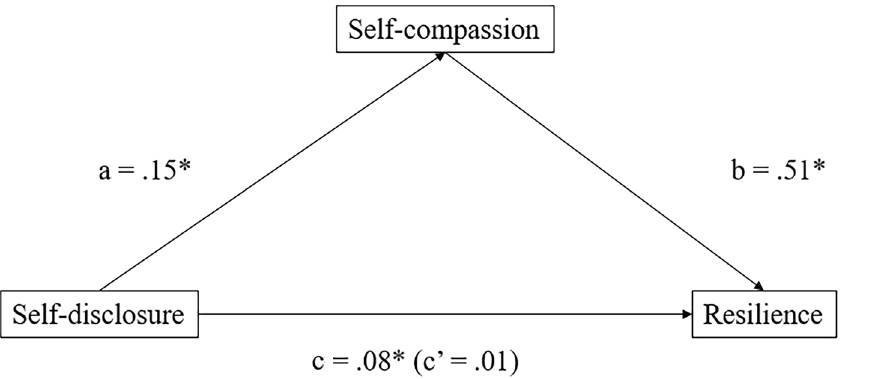
Self-Compassion, Self-Disclosure, and Resilience Mediation